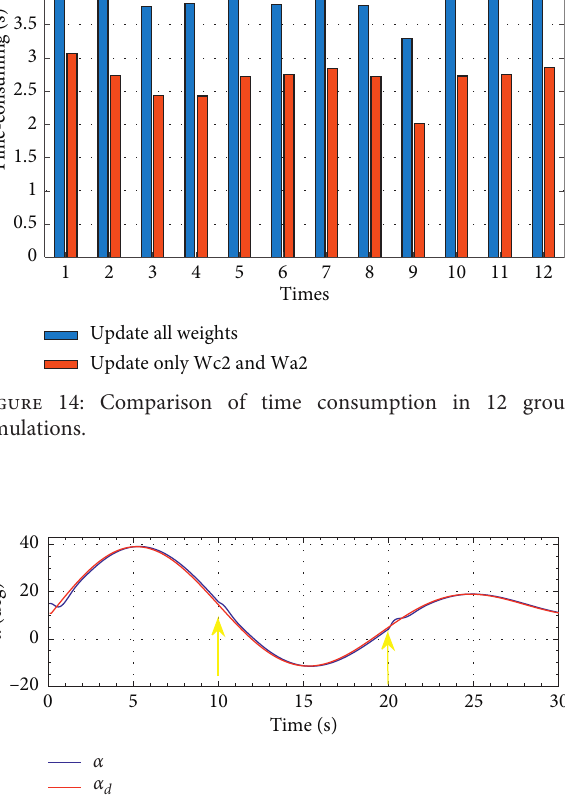
Figure 15: Tracking result of the angle of attack α .